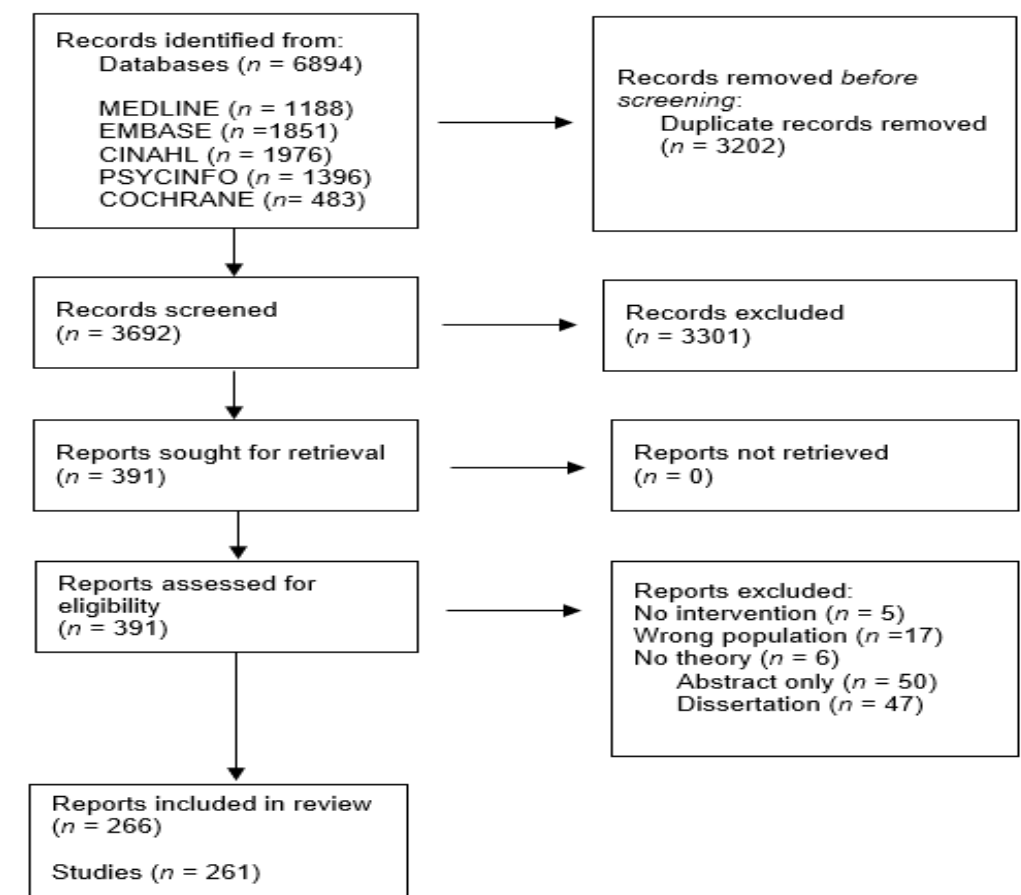
Figure 1. PRISMA flow chart documenting the search and study selection process.